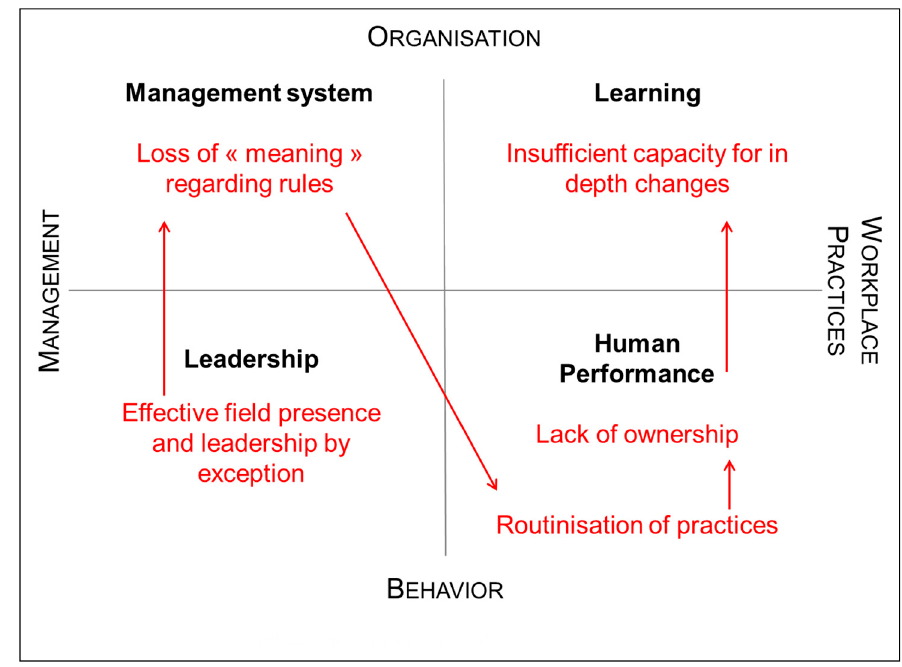
Figure 3. Cultural picture of the installation.